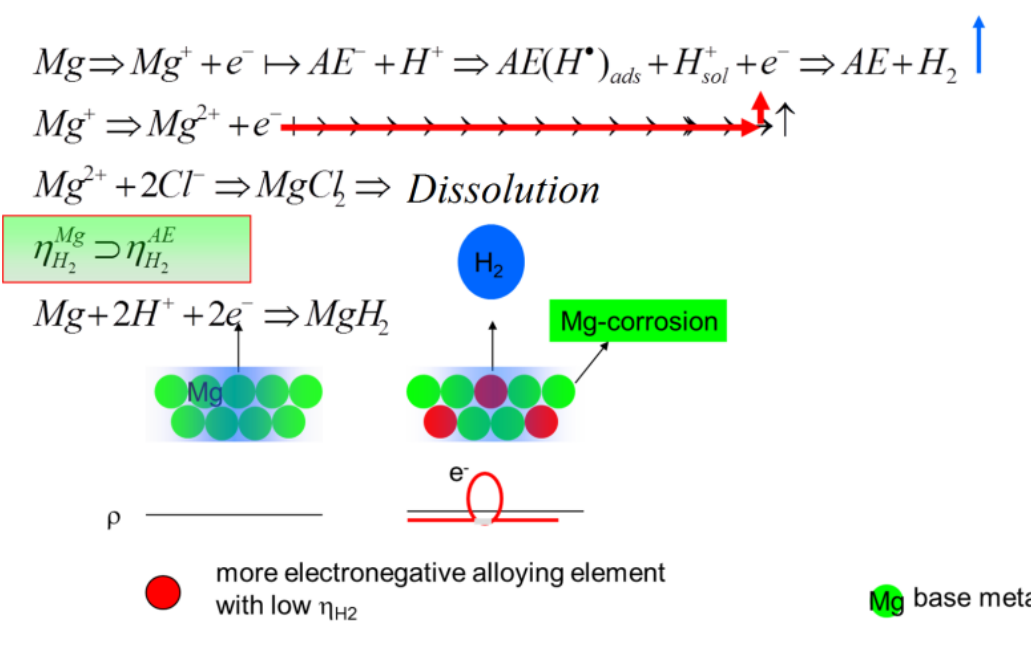
Figure 8. The scheme to describe the effect of the electronegative alloying elements in dependence of the study of Ezaki et al.